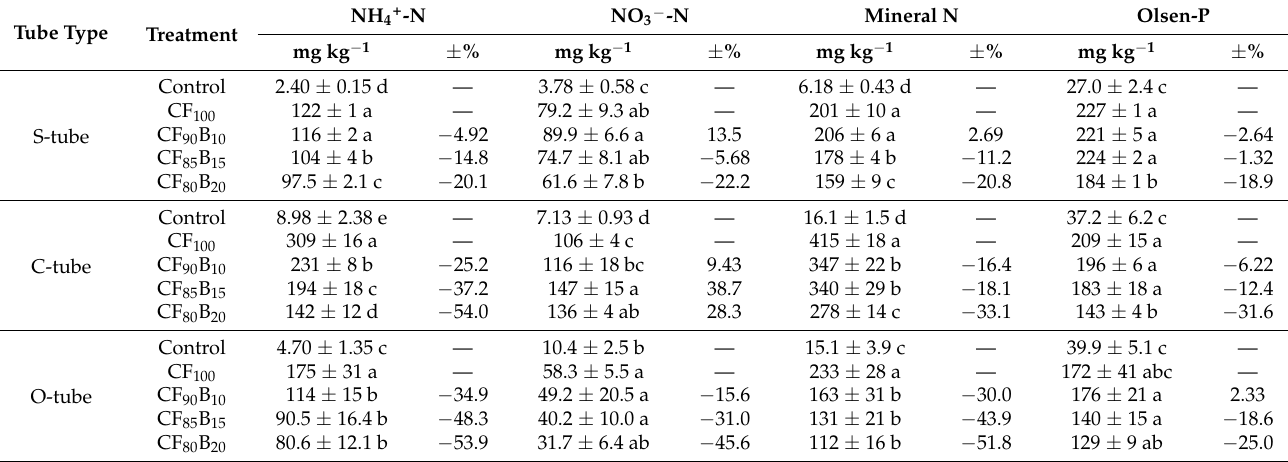
Table 4. Concentrations of mineral N (NH 4+ -N and NO 3 − -N) and available P (Olsen-P) (mg kg − 1 ) in 0–40 cm soil layer in three types of tubes and their percentage changes ( ± %) in the palm silk biochar (PSB)-based fertilization relative to 100% conventional fertilization